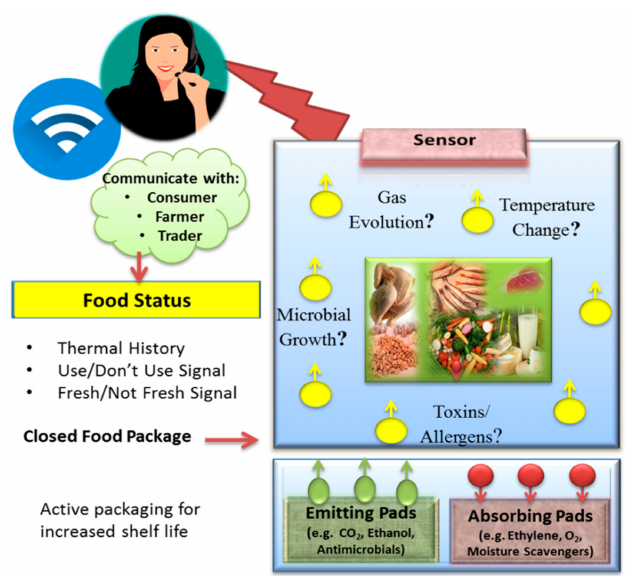
Figure 1. Representation of the concept of smart and active packaging technology.